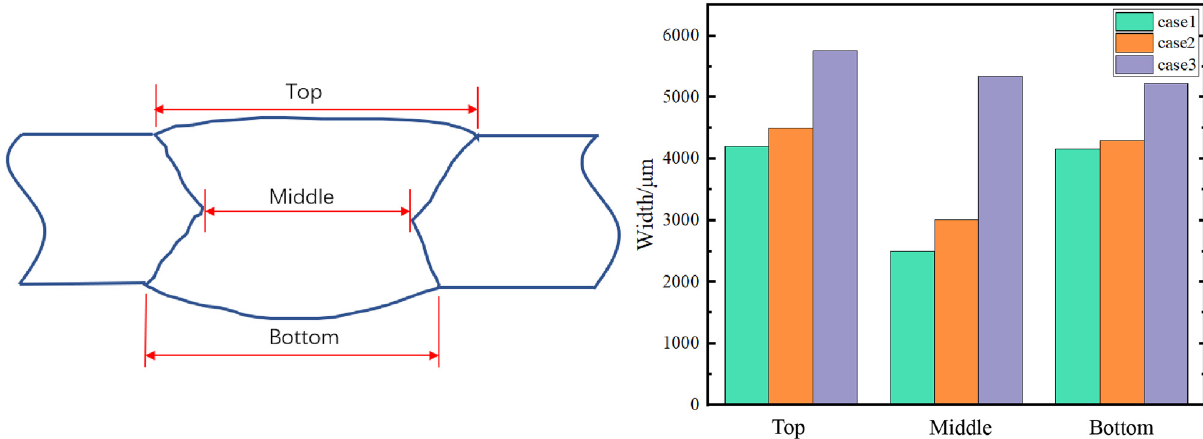
Figure 9: Width of the weld seam of di ff erent